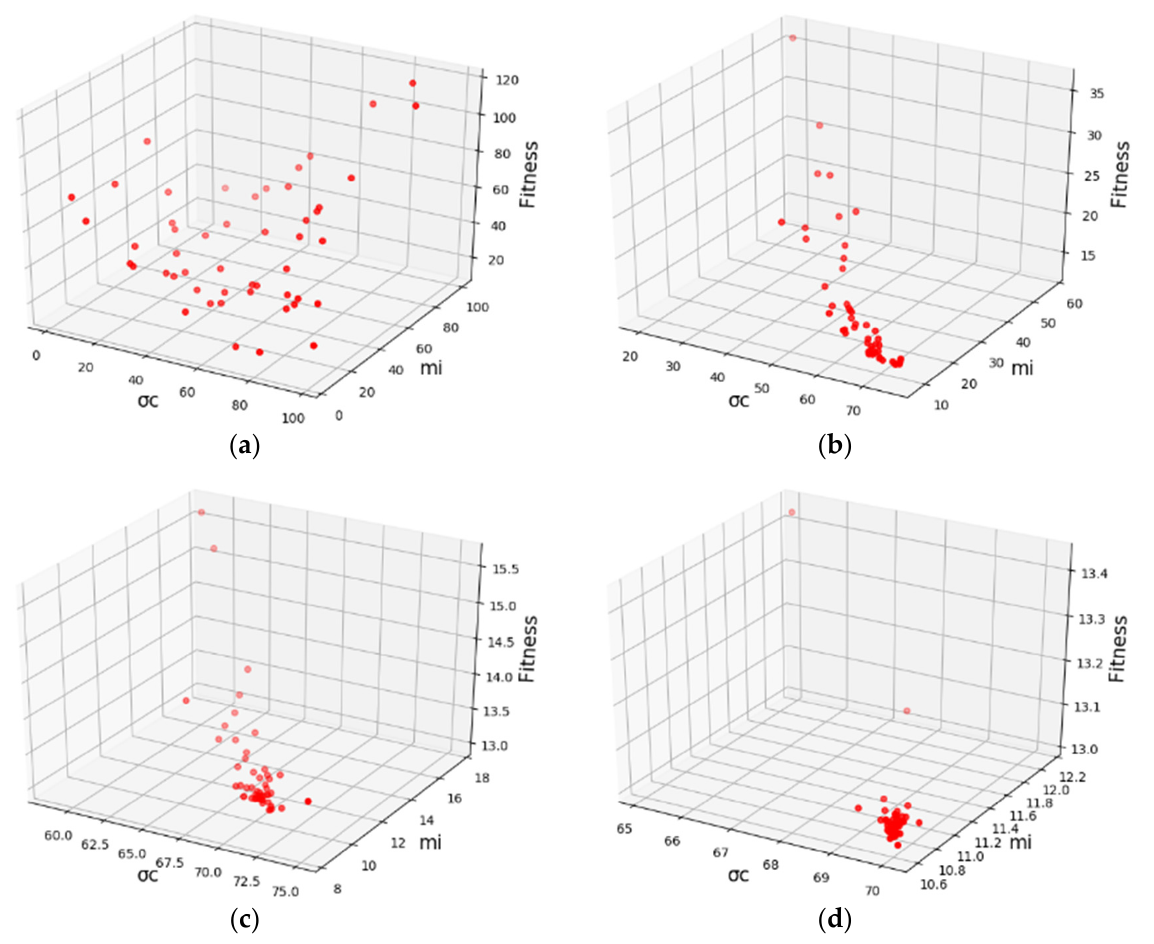
Figure 10. The fitness value of population with the cycle: ( a ) initial cycle, ( b ) cycle 20, ( c ) cycle 40, and ( d ) cycle 60.